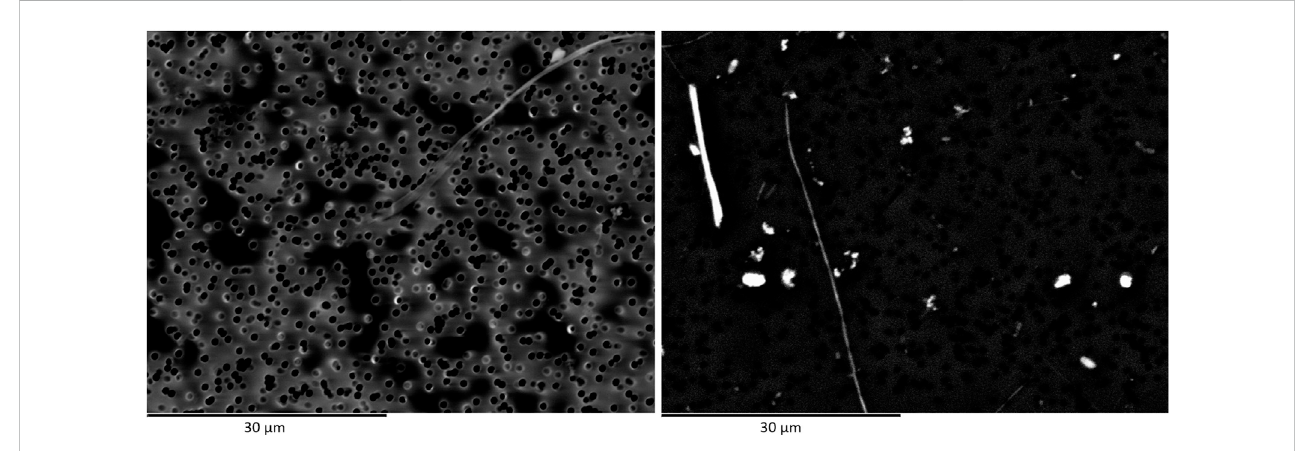
FIGURE 3 Secondary electron images of two different portions of the same membrane fi lter. Comparison between Au-layer (left image) and C-layer (right image) coating.